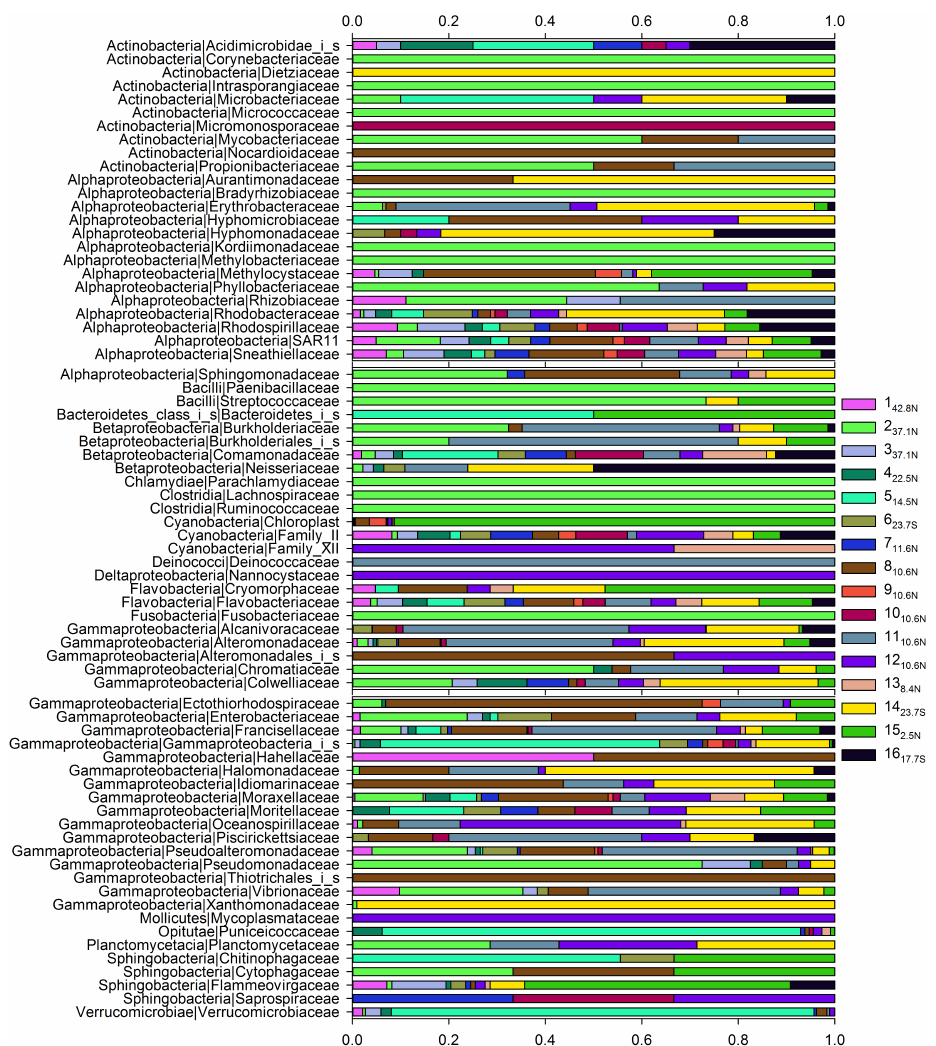
Fig. 3. Relative abundance and affiliation of the 72 bacterial taxonomic families identified in this study with > 50% RDP classifier bootstrap support. A total of 962 OTUs (34%) were assigned taxonomy to the family level, representing 58% of the total read abundance. The size of the bars represents the proportion of the particular family in a sample. Incertae sedis is denoted as “i s”. Each color corresponds to a different sample (1–16) with the latitude of the sampling location as a subscript in the